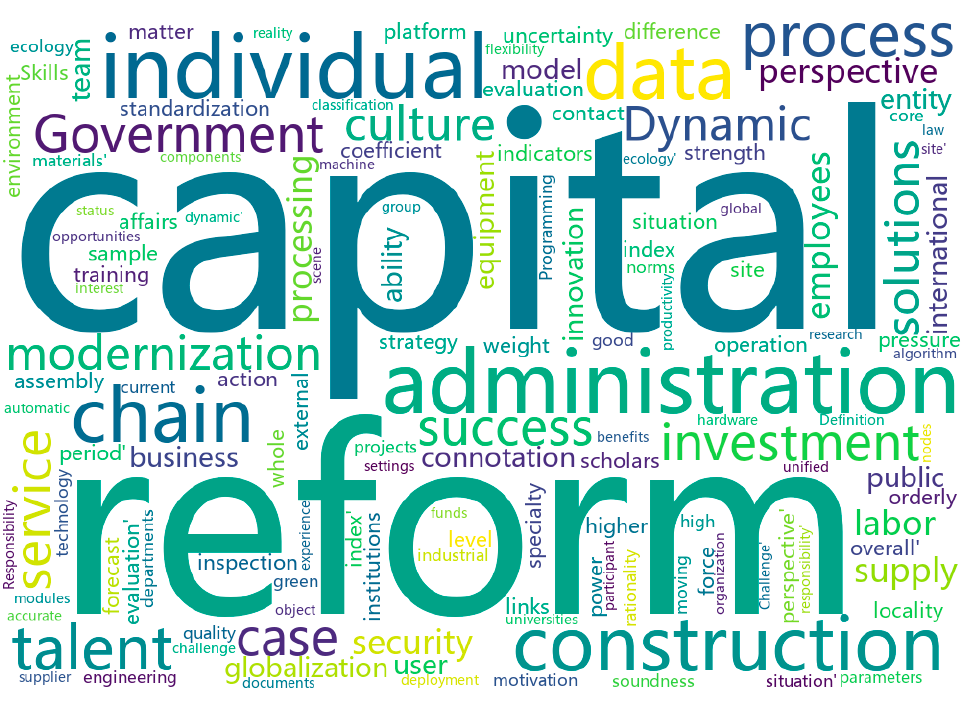
Figure 3. A word cloud map based on the top 100 word frequency.